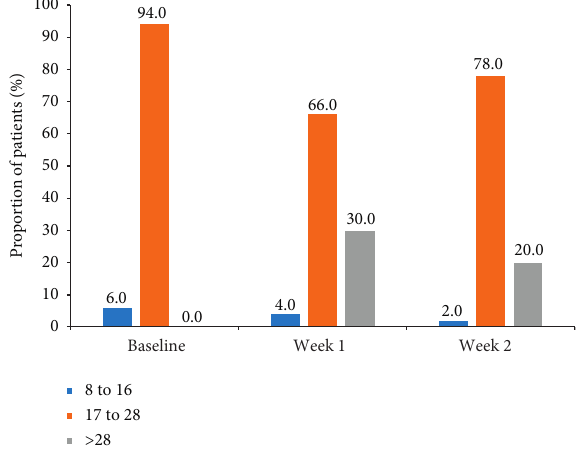
Figure 3: Proportion of patients by CNAQ score ranges (ITT population) ∗ . ∗ ITT population including all patients who are an- alyzed in the study. CNAQ, Council on Nutrition Appetite Questionnaire; ITT, intention to